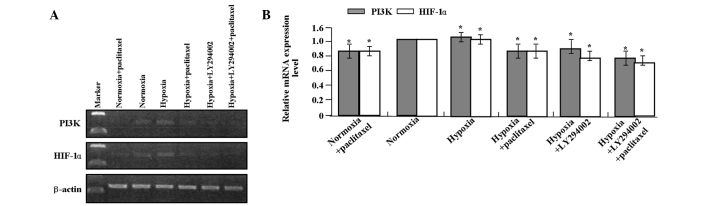
Effects of LY294002 and/or paclitaxel on the mRNA expression of PI3K and HIF-1α. (A) Quantitative polymerase chain reaction was performed to detect the mRNA expression levels. (B) LY294002 combined with paclitaxel markedly reduced the mRNA expression levels of PI3K and HIF-1α compared with the single treatment of LY294002 or paclitaxel (each P<0.01). LY294002 or paclitaxel decreased the RNA expression levels of PI3K and HIF-1α compared with the hypoxia group. *P<0.01 compared with normoxia. PI3K, phosphatidylinositol-3-kinase; HIF-1α, hypoxia-inducible factor-1α.